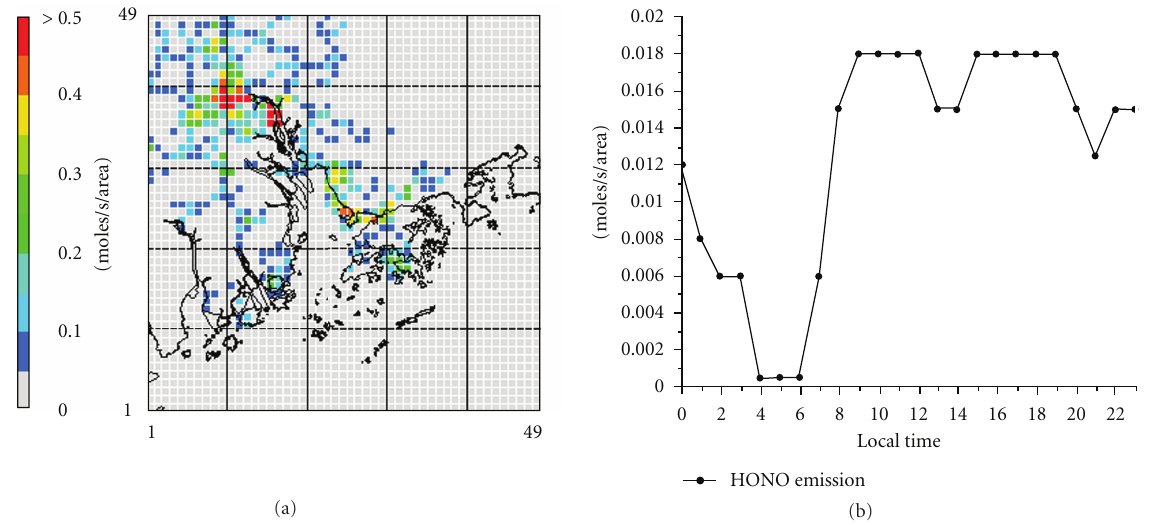
Figure 2: (a) Average daily HONO emission rate (moless − 1 gridarea − 1 ) distribution pattern and (b) diurnal profile of HONO emission in the PRD